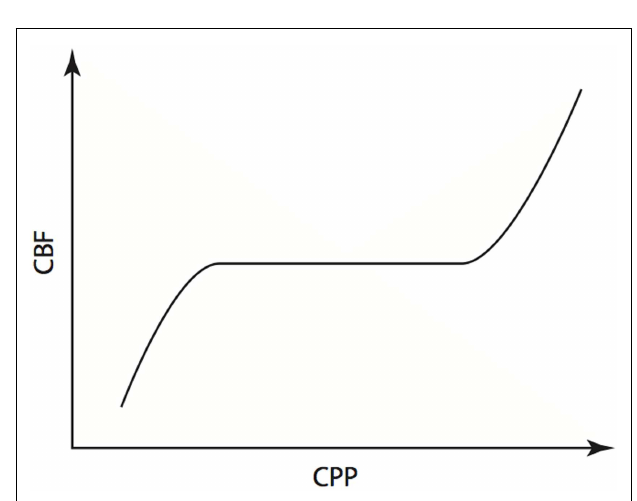
FIGURE 7 | ICP plse versus ICP relationship [adapted fromAvezaat and van Eijndhoven (31)] . ICP plse plotted against ICP, demonstrating a direct linear relationship. A breakpoint occurs at an ICP of approximately 60mmHg where the slope of the relationship increases.